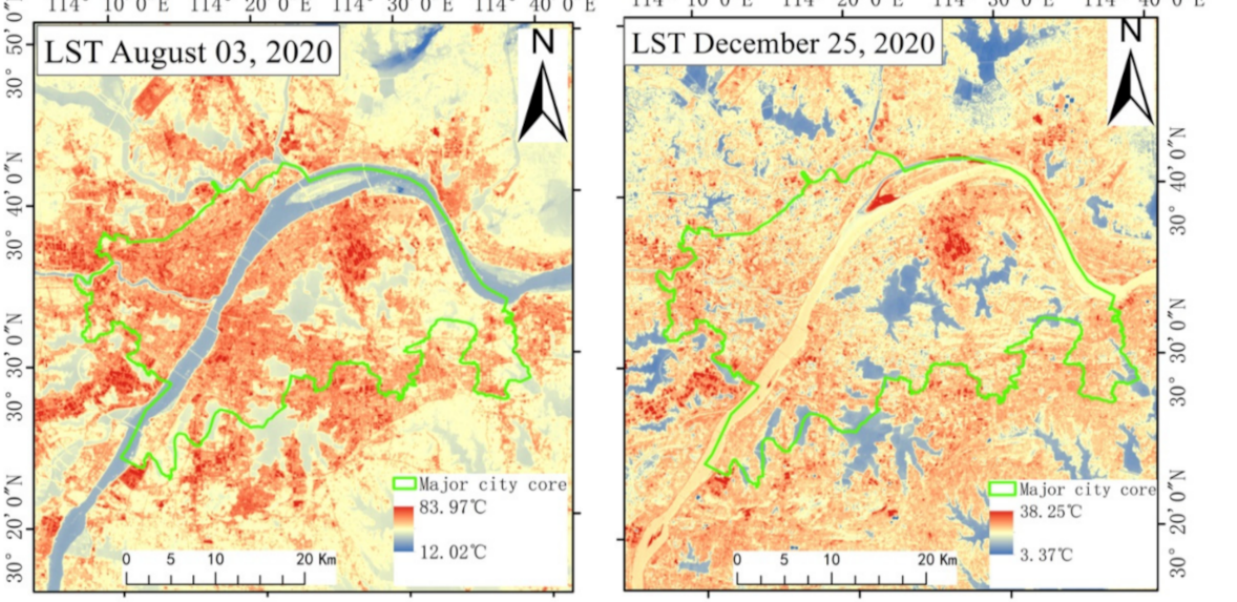
Figure 5. LST in summer ( left ) and in winter ( right ) in